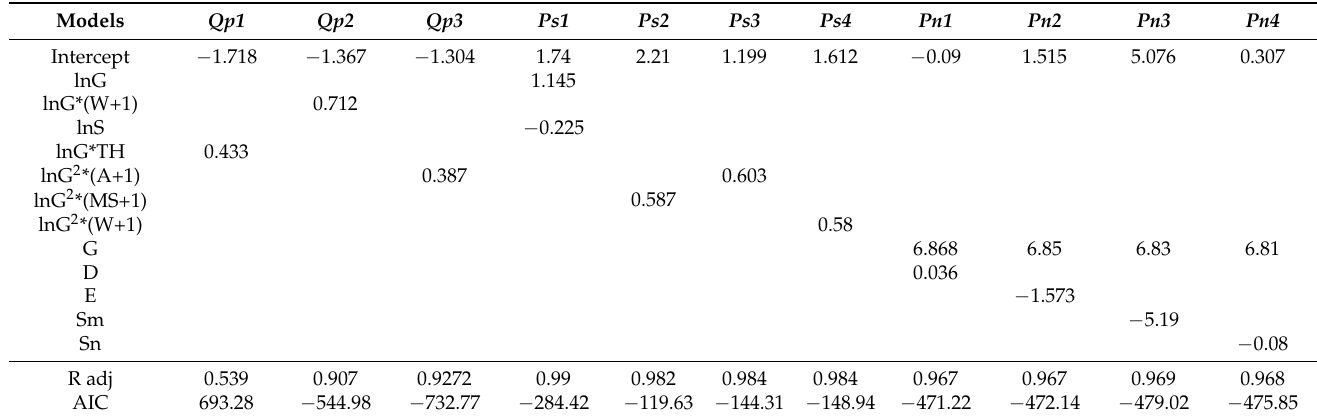
Table 6. Selected models by species in the Valdepoza